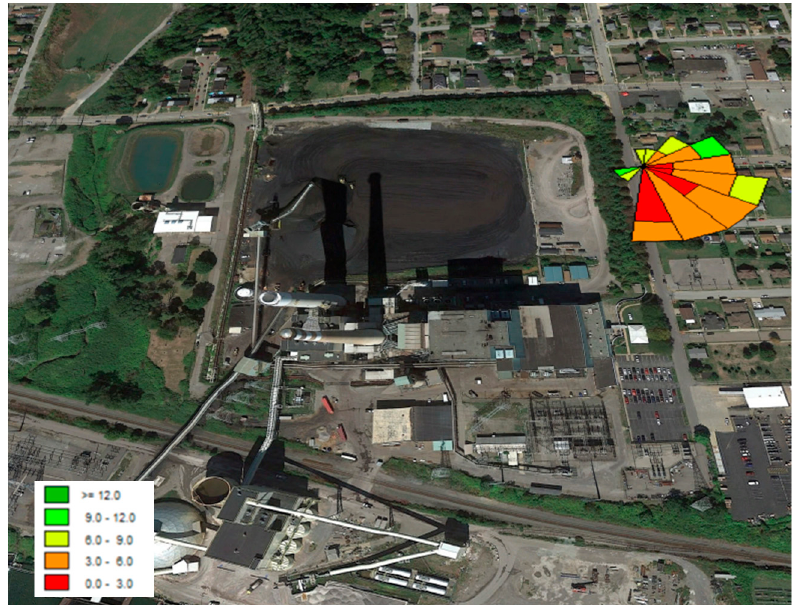
Figure 6. Wind rose created for PM 2.5 concentrations measured at Station 1. Green colors represent the highest concentrations of particulate matter while the orange and red colors represent lower concentrations of particulate matter, as shown in the legend. Units of particulate matter concentration are μ g m − 3 . The upper side of the wind rose represents North. The length of the wind rose vectors represents average wind speed, where the longer vectors represent a higher average wind speed. Atmosphere 2017 , 8 , 186